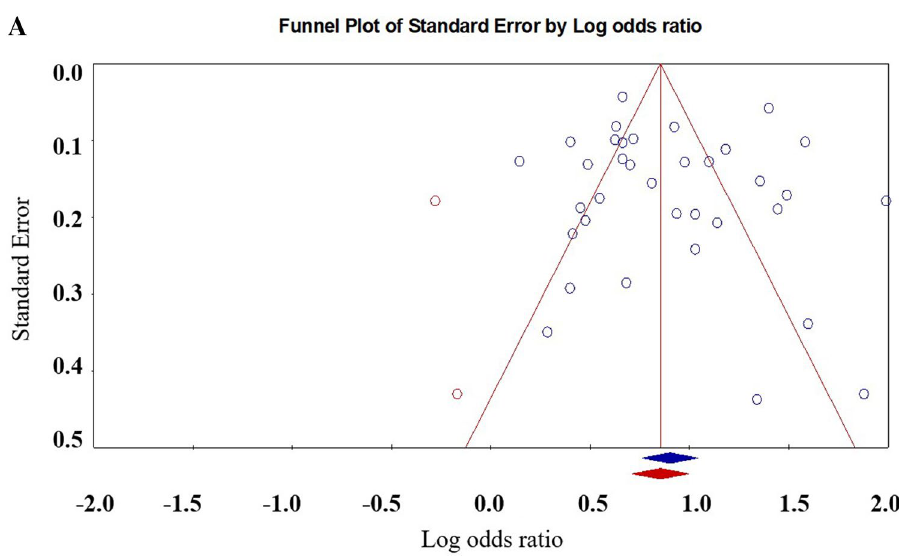
Figure 3. Filled funnel plot of the relationship between non-suicidal self-injury and being